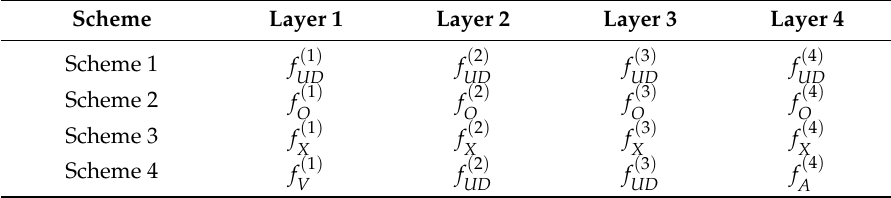
Table 5. Definition of the through-the-thickness distribution of the reinforcing fibers.